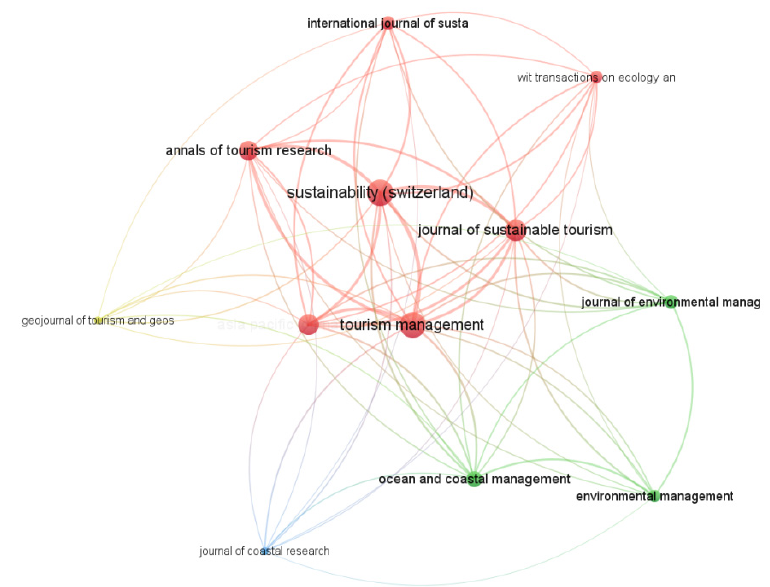
Figure 3. The coupling relationship between journals on the theme of TECC.